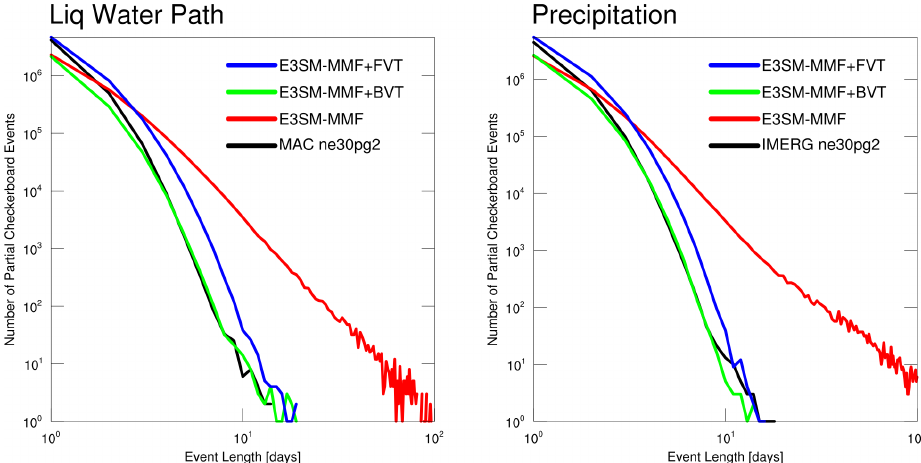
Figure 5. Histogram of the event length, with events defined as continuous periods with partial checkerboard neighborhood states. Data were restricted to oceanic points equatorward of 60 ◦ latitude in both hemispheres for all 5 years